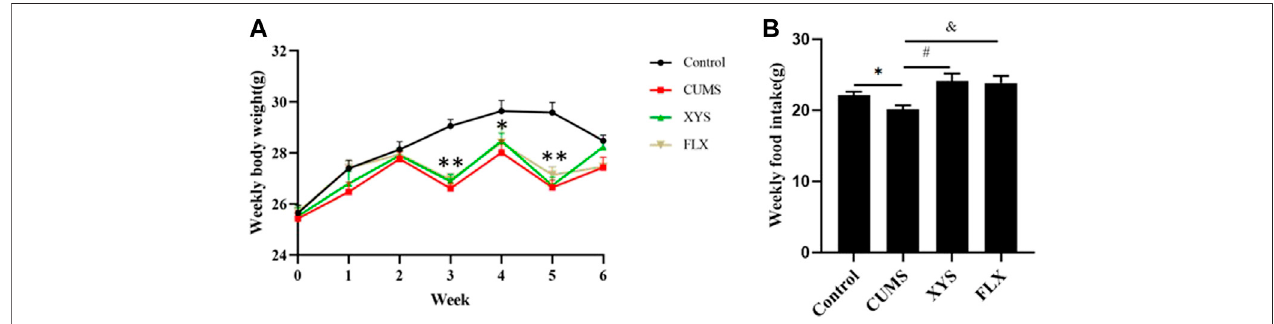
FIGURE 2 | Effects of CUMS, Xiaoyaosan, and fl uoxetine on the weekly body weight gain and daily food intake of the mice. (A) Weekly body weight (F (3, 44) = 20.310, p < 0.0001, n = 12) (B) Weekly food intake (F (3, 20) = 7.885, p = 0.0092, n = 12). The values shown represent the mean ± SEM. p p < 0.05 or pp p < 0.01 compared with the control